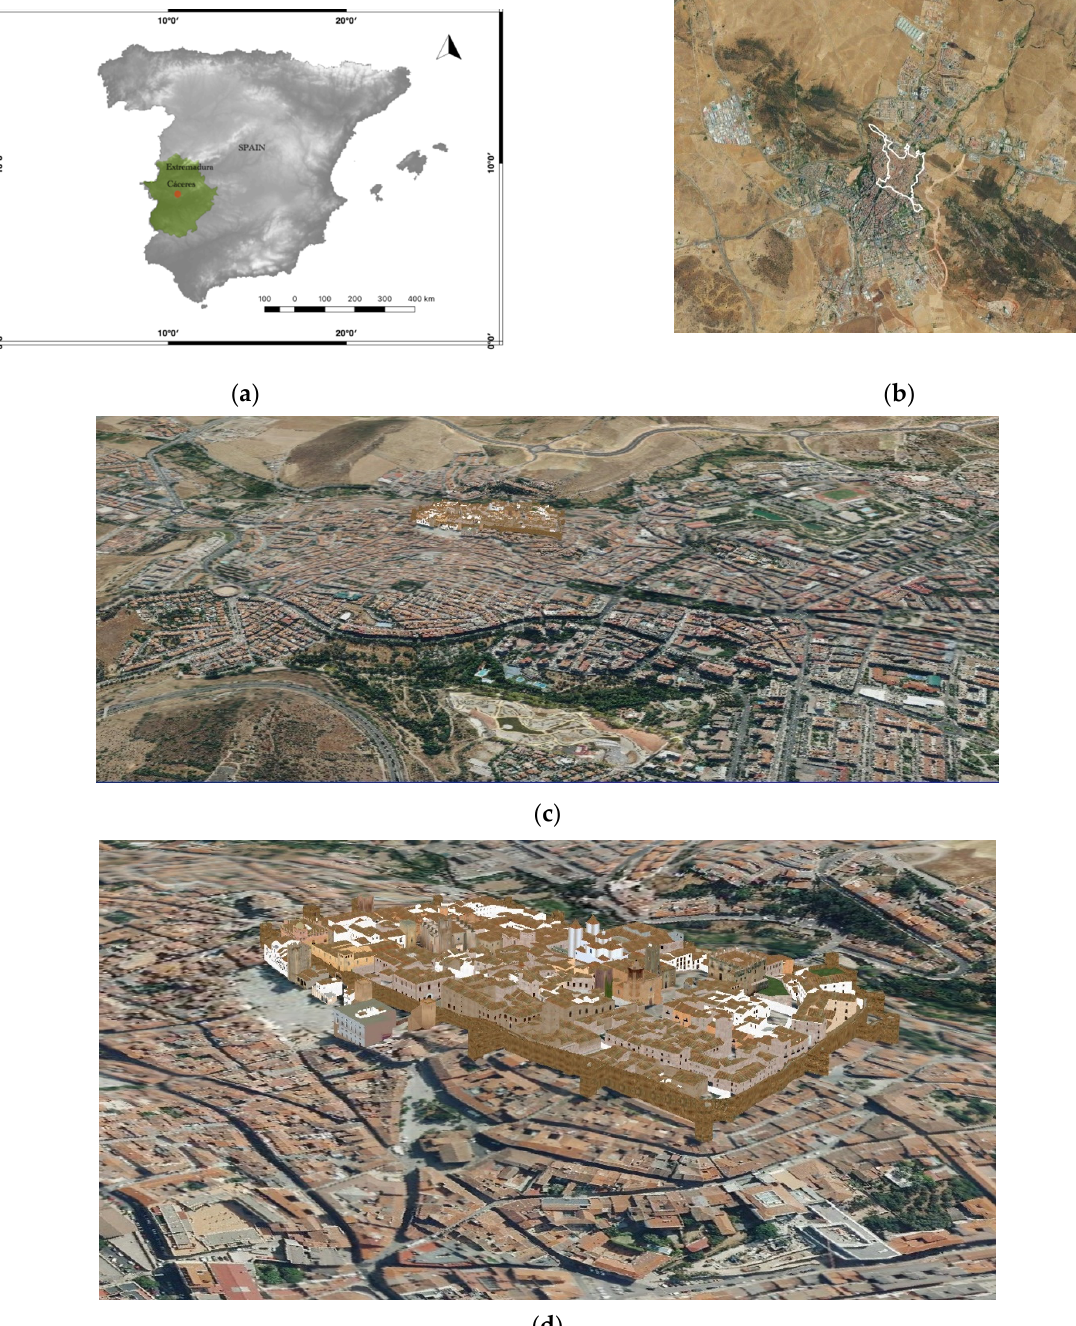
Figure 1. Geographical location of the study area: ( a ) Location of Cáceres in the region of Extremadura (Spain). ( b ) Orthoimage of the city of Cáceres and boundaries of the historic centre of Cáceres according to “Plan Cáceres Histórica” (marked with a white line). ( c ) panoramic view. ( d ) 3D imageof historic centre of Cáceres [25].